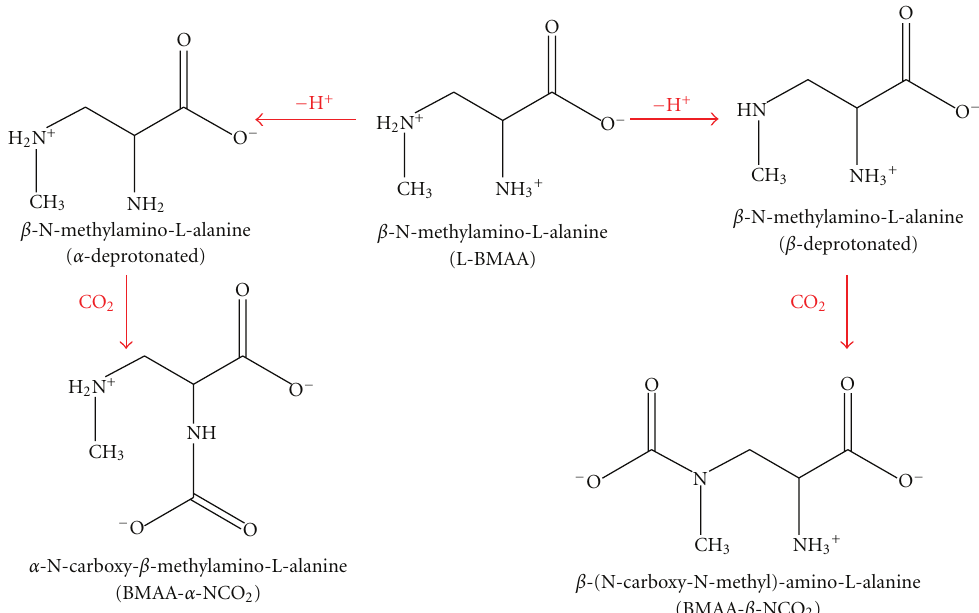
Figure 1: Reaction of the α - and β -amino groups of BMAA with CO 2 to form the corresponding carbamate adducts (after [65,